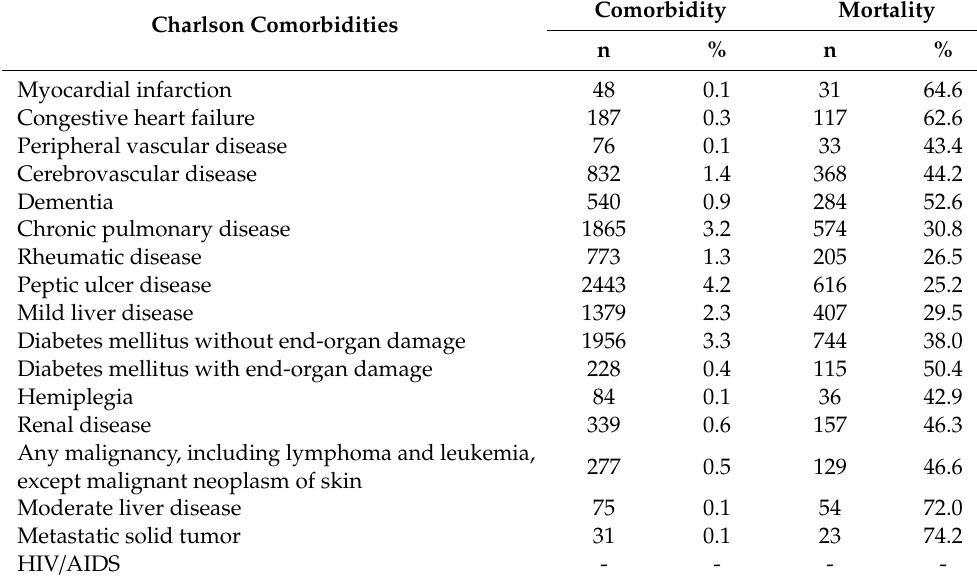
Table 2. Distribution of Charlson Comorbidities and Mortality in Patient Cohort (n = 58,771). Comorbidity Charlson Comorbidities